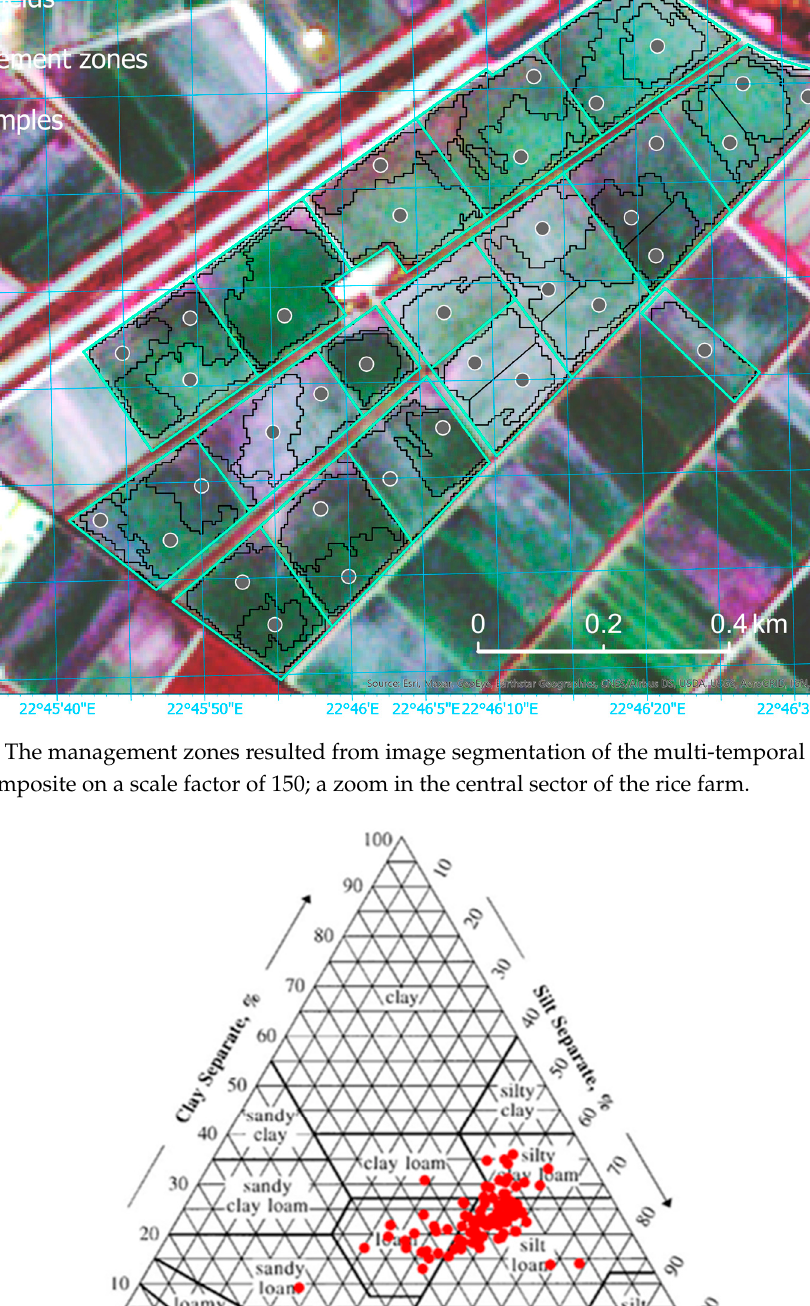
Figure 5. Within-zone and between-zone variation (computed as CV%) for an experimental sequence of segmentation scale factors (25 to 300) for the multi-temporal RapidEye PC1 image.